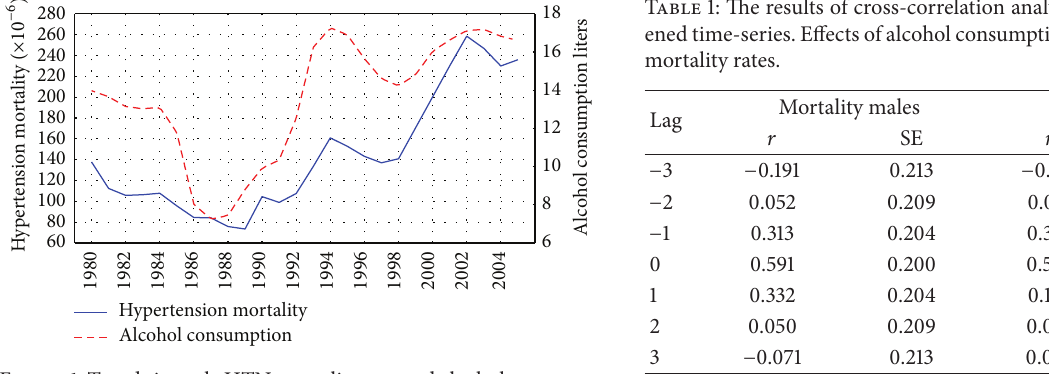
Figure 1: Trends in male HTN mortality rate and alcohol consump- tion per capita in Russia between 1980 and 2005.